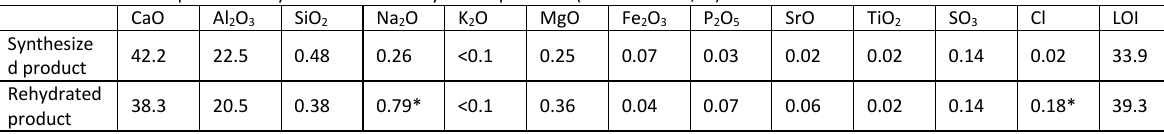
Table 1. Chemical composition of synthesized and rehydrated products (mass fraction, %).